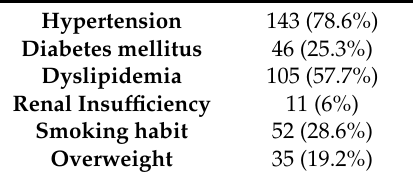
Table 3. Study population cardiovascular risk